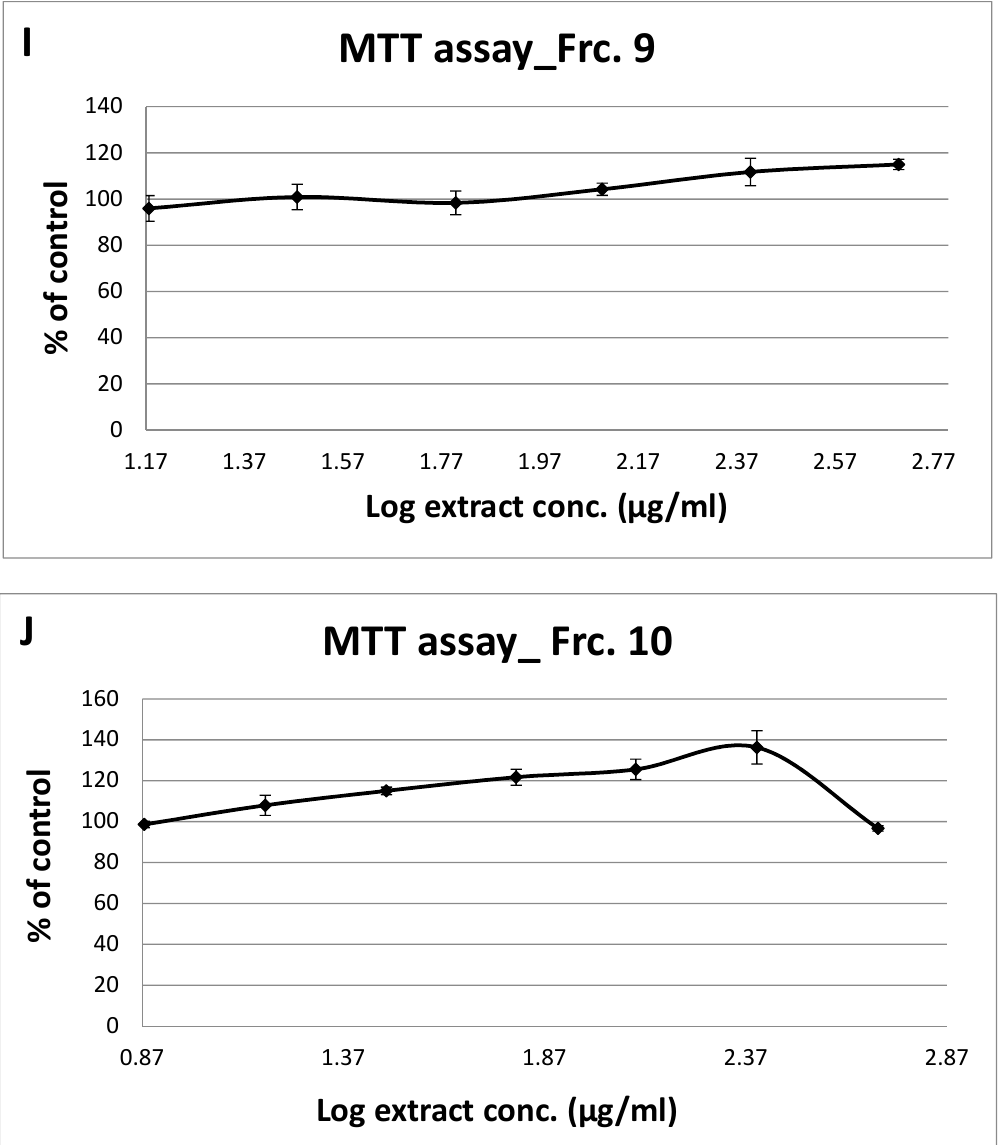
Figure 2. Effect of the Ten Gundelia T. fractions ( A – J ) on cell viability by MTT assay. L6-GLUT4myc cells (20,000 cell/well) and exposed to GT fractions for 20 h. Values given represent means ± SEM (% of untreated control cells) of three independent experiments carried out in triplicates.